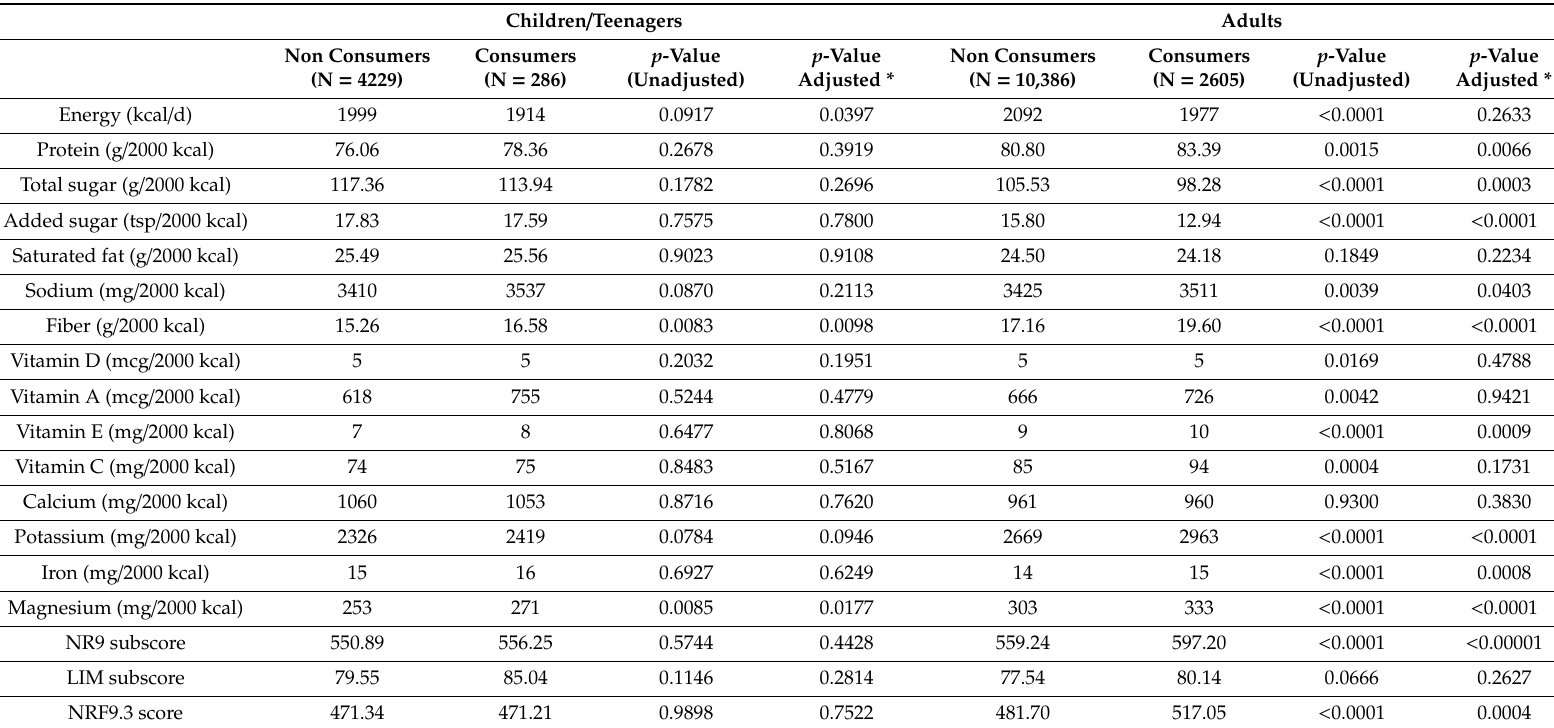
Table 3. Energy and nutrient intakes (adjusted for 2000 kcal) and Nutrient-Rich Foods (NRF9.3) scores and NR9 and LIM subscores for tea consumers and non-consumers shown for children and